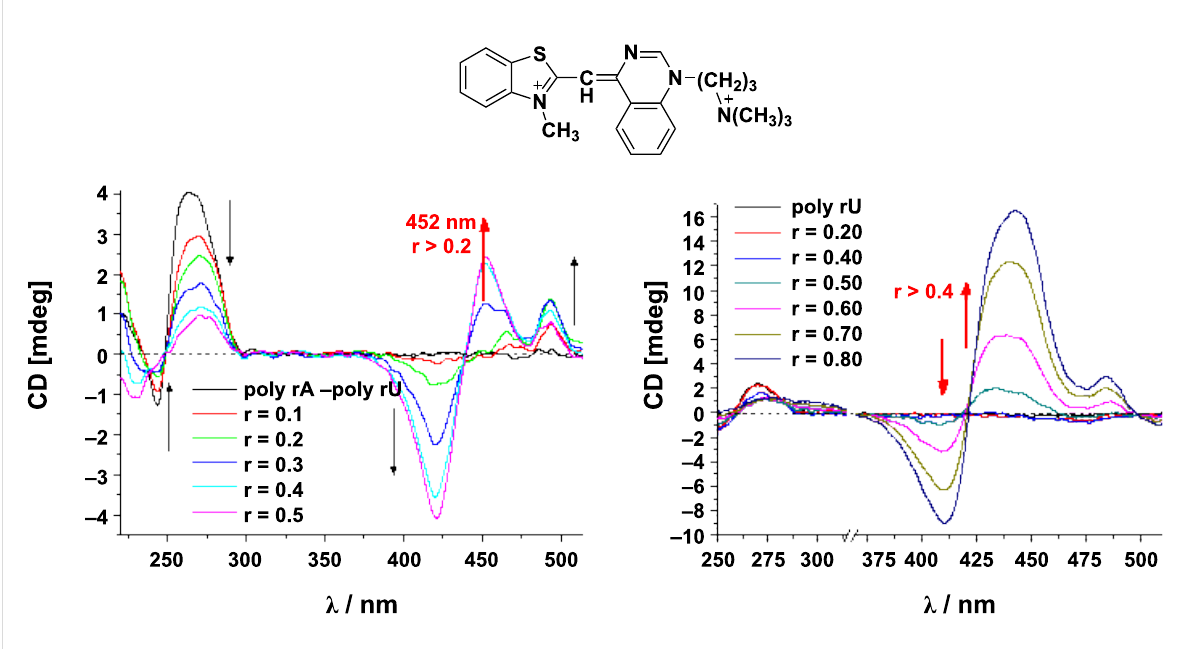
Figure 8: CD titration of poly rA-poly rU (left) and poly rU (right) ( c (polynucleotide) = 2.0 × 10 − 5 mol dm − 3 ) with ligand L at molar ratios r = [L]/[poly- nucleotide] (pH 7.0, sodium cacodylate buffer, I = 0.05 mol dm − 3 ). Adapted from